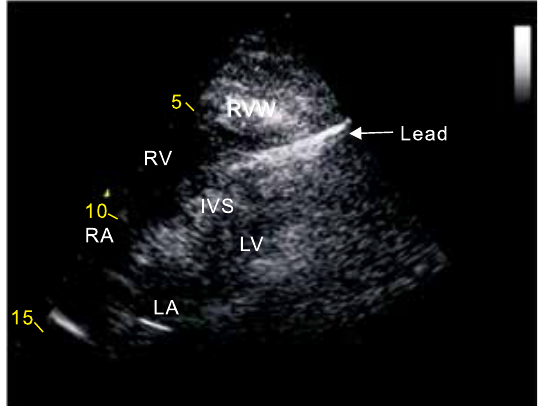
Figure 1 Two-dimensional transthoracic echocardiography with pacer lead shown in subcostal view. The arrow points to the lead through the RV apex, without pericardial effusion. RVW, right ventricular wall; RV, right ventricle; RA, right atrium; LV, left ventricle; LA, left atrium; IVS, interventricular